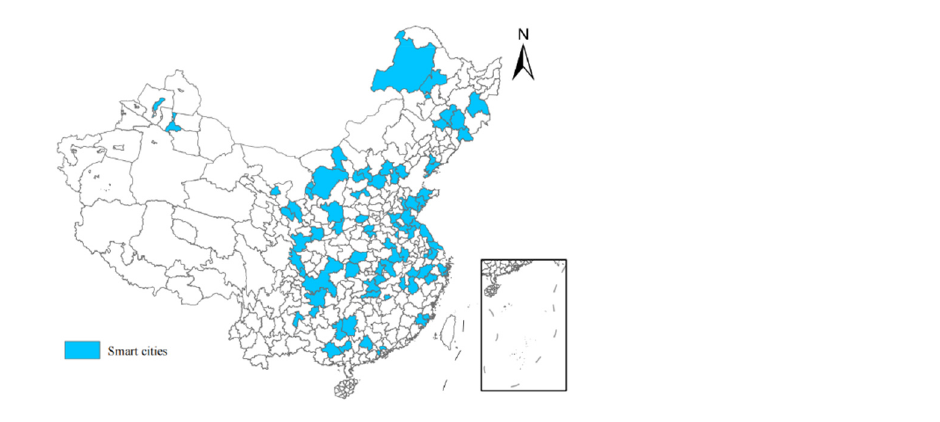
Figure 3. Smart cities pilot. Table 7. Policy effect of SCP